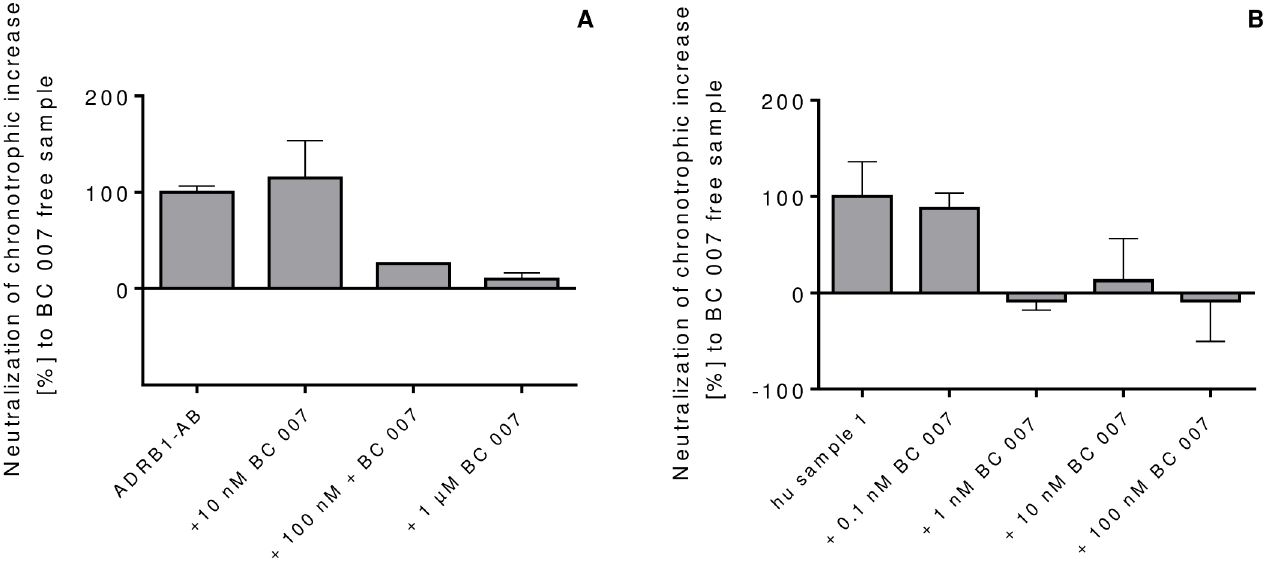
Fig 8. Inhibition of beta1-AAB activity by increasing concentration of BC 007. A: ADRB1-AB 6.7 nM and increasing amounts of BC 007 as indicated in the figure legend and B: human sample no. 1 and increasing concentration of BC 007 as indicated in the figure legend. Data represent mean of one experiment, 6 technical